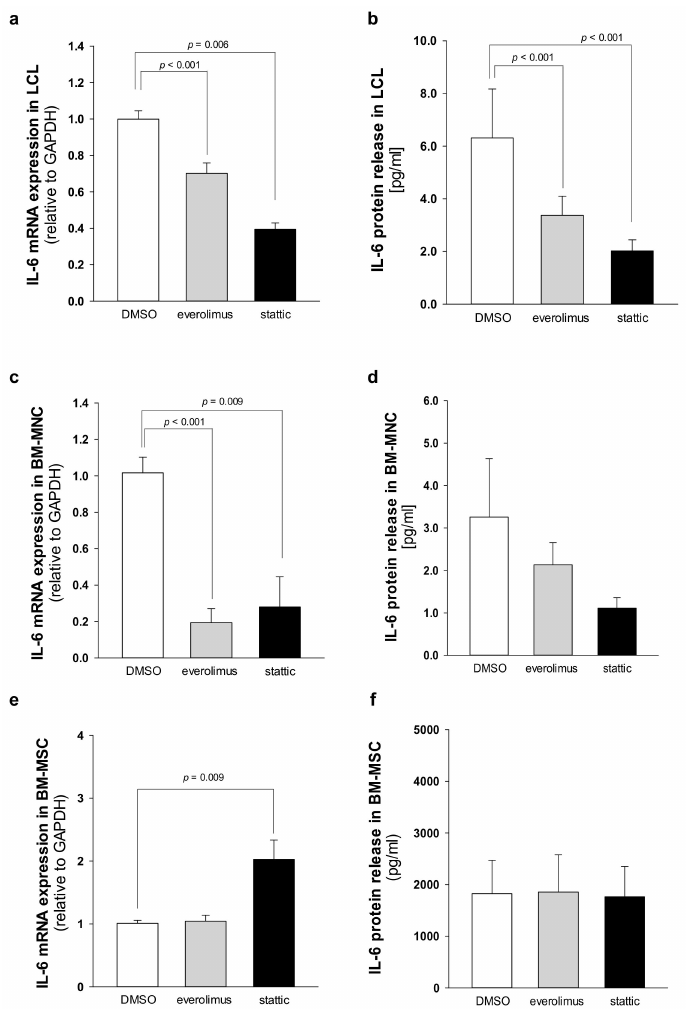
Figure 7. Everolimus and stattic inhibit IL-6 expression in SDS patient-derived hematopoietic cells. ( a ) IL-6 transcript expression in LCL incubated in the absence (DMSO) or in the presence of 350 nM everolimus or 7.5 µ M stattic for 24 h was quantified by qRT-PCR. Data are mean ± SEM of six experiments performed in duplicate from three a ff ected individuals (UPN58, UPN75, and UPN106). ( b ) IL-6 release in supernatants collected from LCL incubated in the absence (DMSO) or in the presence of 350 nM everolimus or 7.5 µ M stattic for 24 h, as measured by Bio-plex assay. Data are mean ±